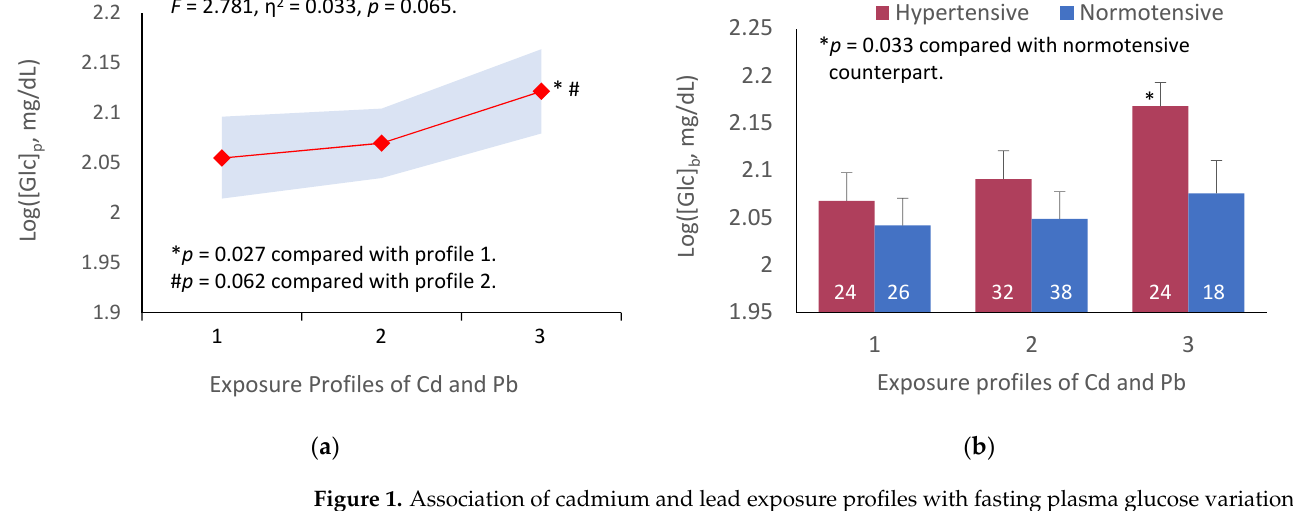
Figure 1. Association of cadmium and lead exposure profiles with fasting plasma glucose variation. The color-coded area graph depicts means for fasting plasma glucose levels as log[Glc] p in participants with exposure profiles 1, 2, and 3 together with variability of the means ( a ). The bar graphs compare means for fasting plasma glucose as log[Glc] p in participants with and without hypertension across three profiles ( b ). The number of participants with profiles 1, 2, and 3 are 50, 70, and 52, respectively. The means are obtained by univariate/covariance analysis, adjusted for age and BMI. Bonferroni correction is applied to multiple comparisons.